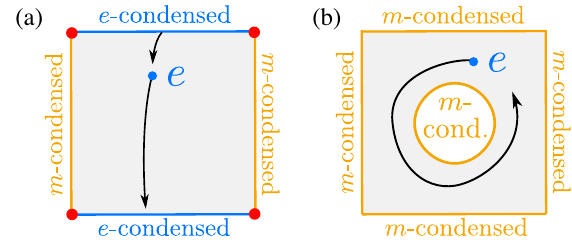
FIG. 15. Topological degeneracy in planar geometry. (a) Alter- nating e - and m -condensed boundaries imply a twofold degen- eracy. One way of understanding this implication is in terms of the Majorana zero modes (red dots) that live at the points where the boundary condition changes [142]; due to the global emergent fermion parity having to be unity, these four Majorana modes give rise to only a twofold degeneracy. If we label states using the P string connecting the left and right boundaries (see the main text), then pulling an e anyon out of one e -condensed boundary to another effectively toggles the states in this two-level system. (b) An annulus geometry with m -condensed boundaries also has a twofold degeneracy. Moving the e anyon around the hole toggles the states. Since e anyons can be created only in pairs, there is another e anyon which we do not move (not shown).